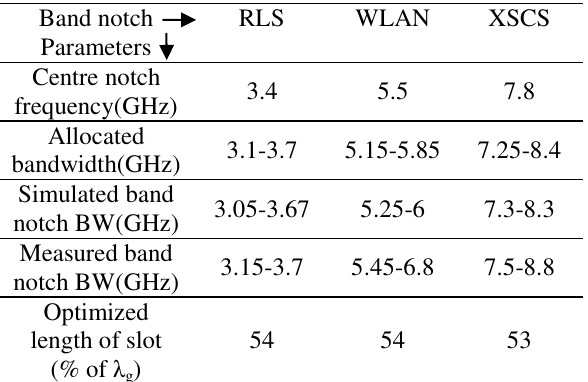
Table 2: Comparison of various characteristics for triple band notches for Antenna-D.